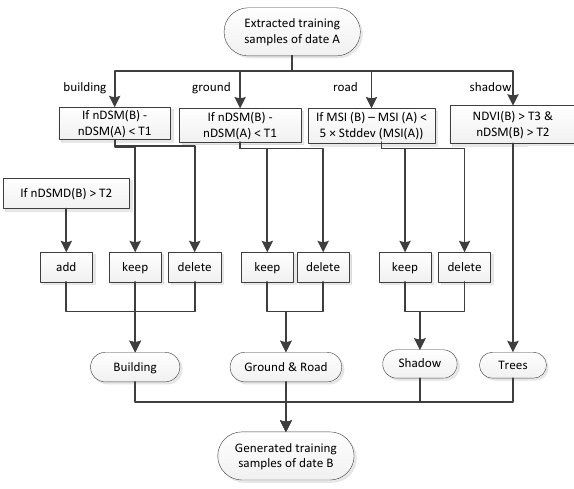
Figure 1. Flow chart for the generation of training